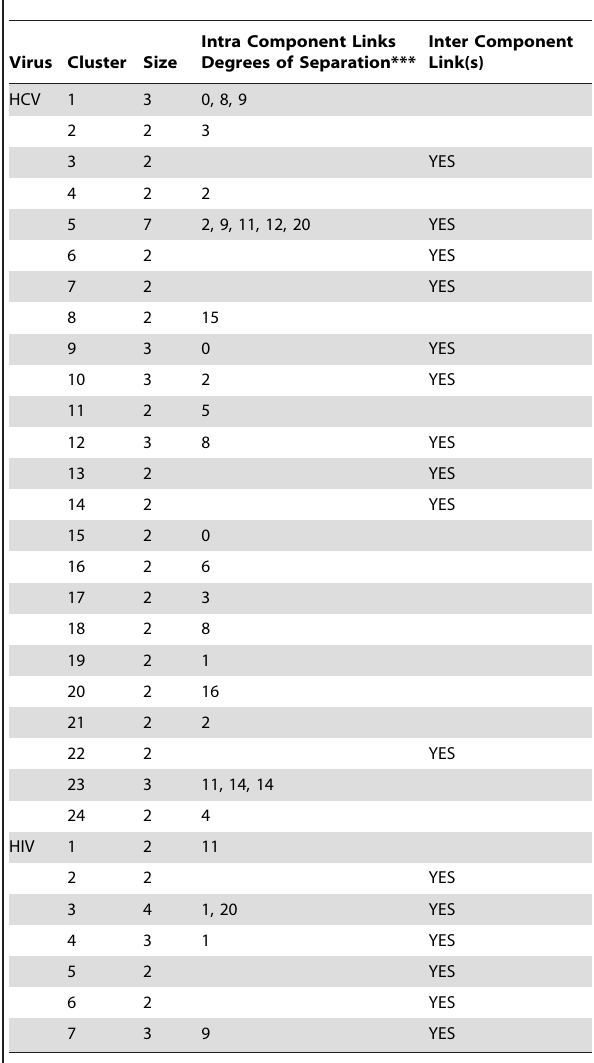
Table 3. Composition of Phylogenetic Clusters and links within and between Network